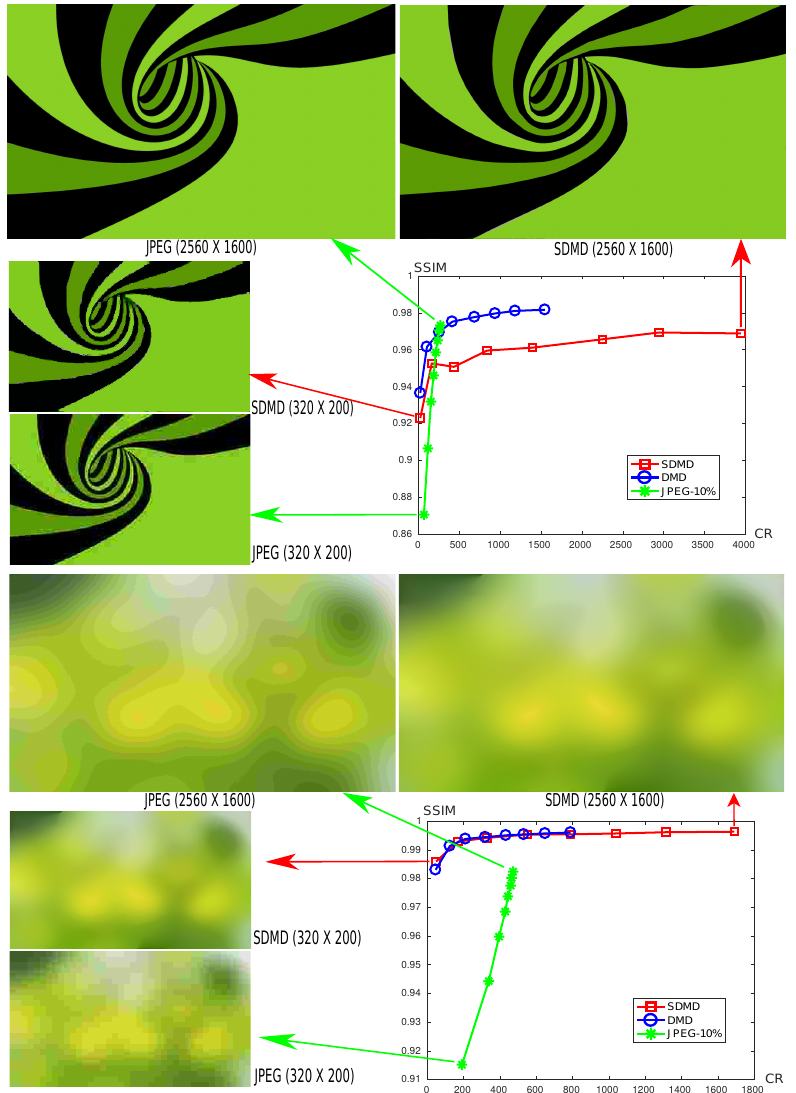
Figure 16. A comparison of SSIM vs. CR for the SDMD (red), CDMD (blue), and JPEG (green) methods for two graphics art images of 8 different resolutions each, from 320 × 200 to 2560 × 1600 pixels. Note that the image sizes shown in the figure are not proportional to their actual sizes, for space